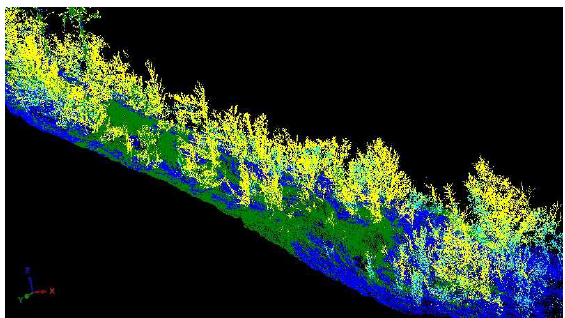
Figure 4: Side view of a small portion of the landslide surveyed with the Riegl VZ-400 laser scanner. Green color denotes single targets, yellow first targets, light blue intermediate targets and blue last